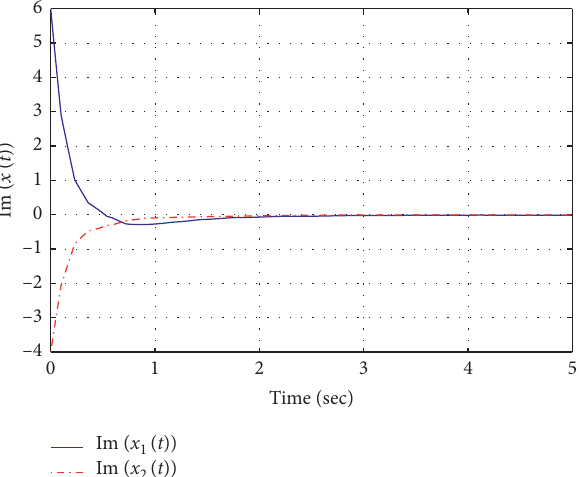
Figure 8: Responses control input u ( t ) of the real part.